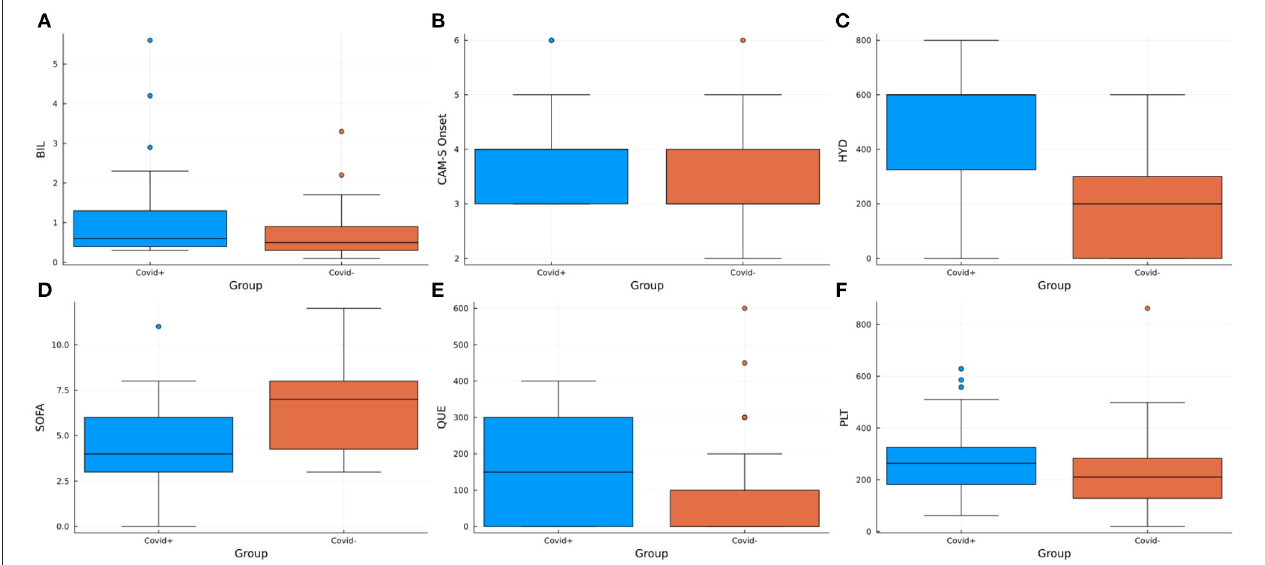
FIGURE 2 | Box plots showing the distribution of the variables resulted significantly different in the comparative analysis between the COV + /DEL + and COV–/DEL + groups. BIL, Bilirubin; CAM-S, Confusion Assessment Method—Short Version; HYD, hydroxyzine; PLT, platelets count; QUE, quetiapine; SOFA, Sepsis-related Organ Failure